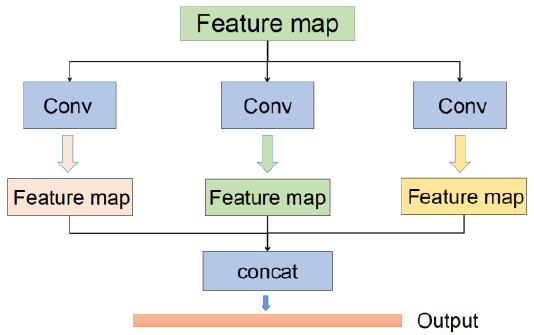
Figure 5. Multiscale